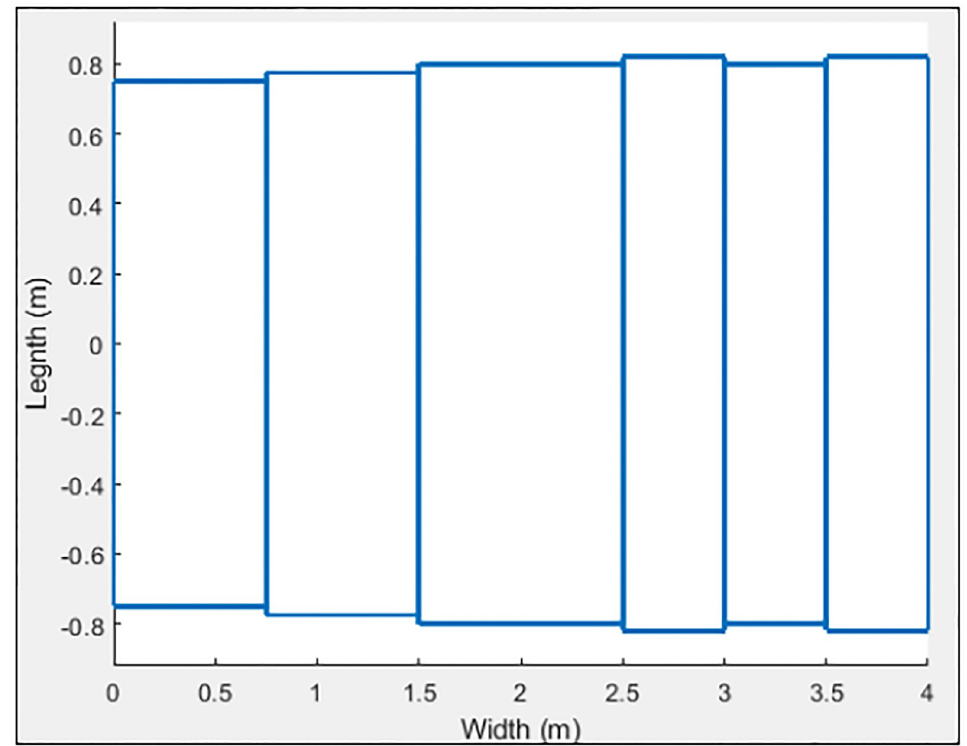
Fig 16. Citroe¨n-15 characterized in 6